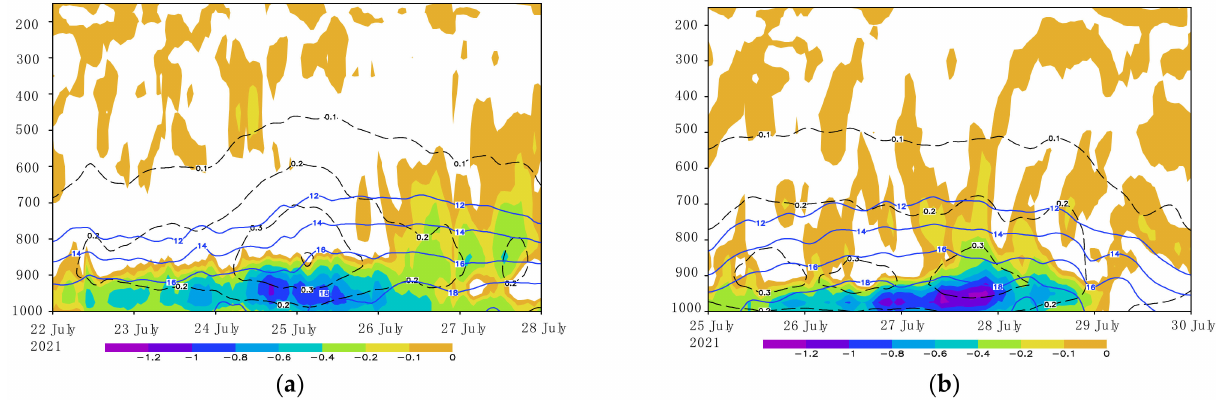
Figure 12. Vertical-time cross-section of regional average water vapor flux (black dashed line, unit: 10 − 4 g cm − 1 hPa − 1 s − 1 ), specific humidity (blue line, unit: g kg − 1 ) and water vapor flux divergence (shaded, unit: 10 − 9 g cm − 2 hPa − 1 s − 1 ) of ( a ) Zhejiang (31–34 ◦ N; 118~121 ◦ E) and ( b ) Jiangsu (31–34 ◦ N; 118–121 ◦ E)